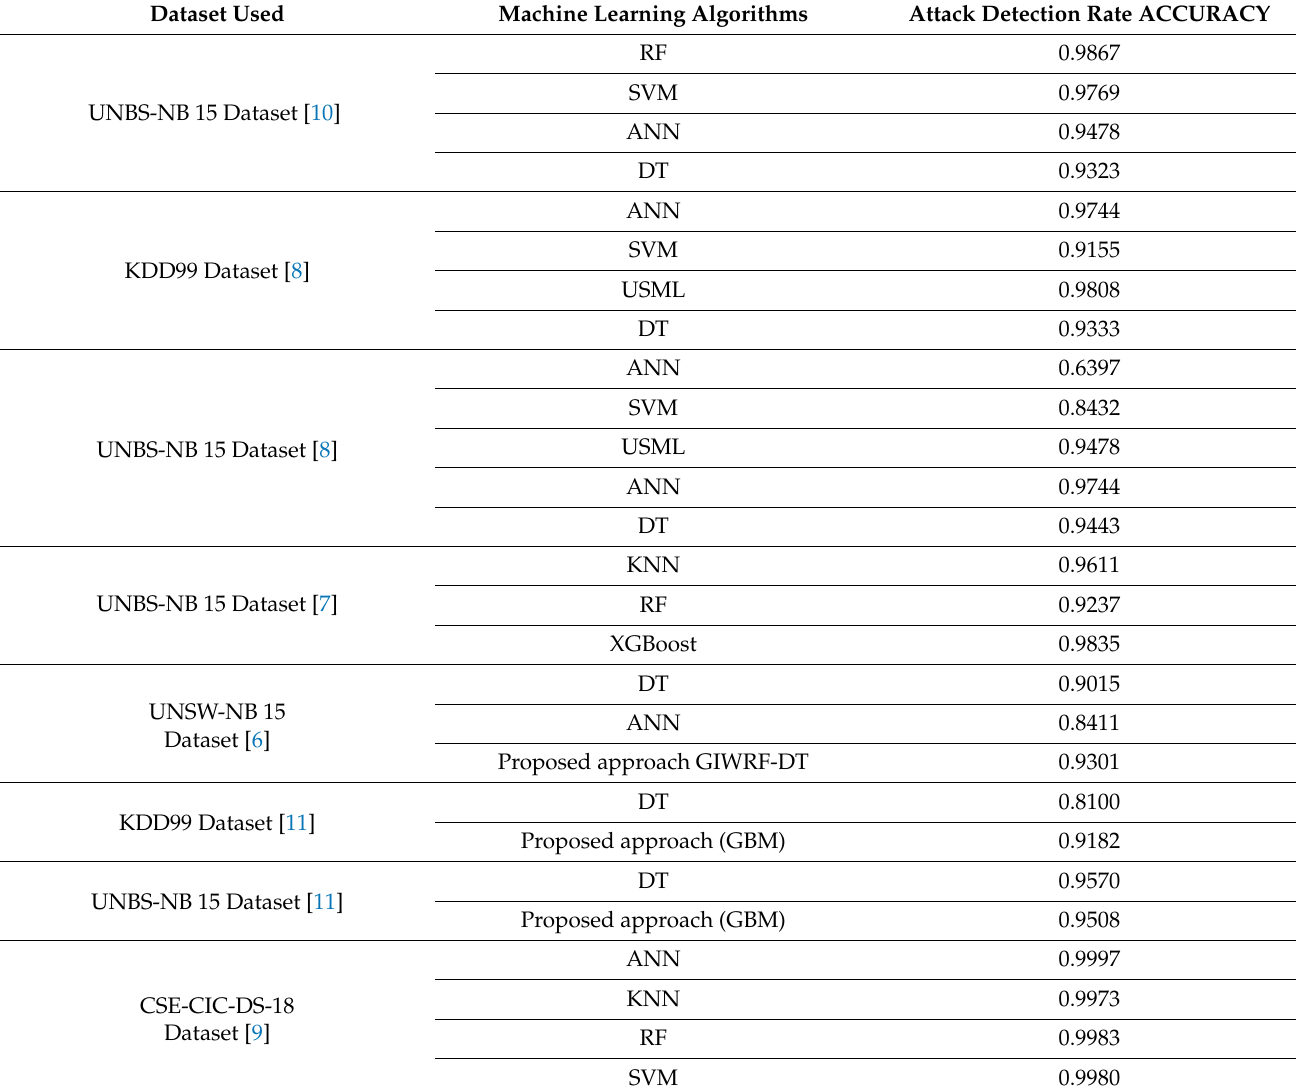
Table 1. Results compared from similar